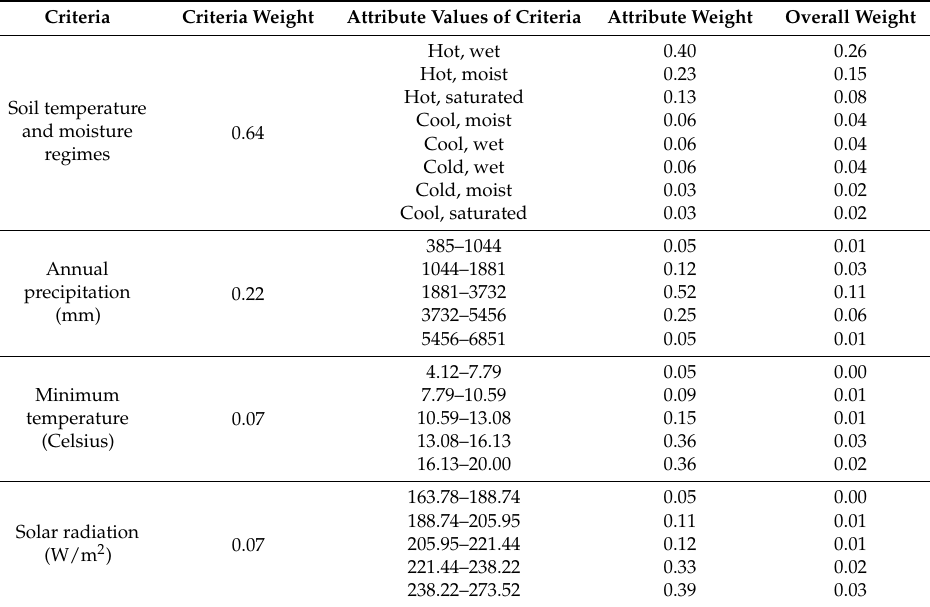
Table 2. AHP results for land suitability for banagrass